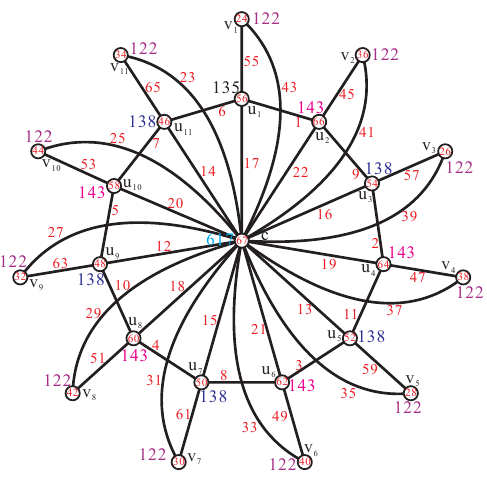
Figure 17. The local antimagic total labeling of F 11 . Example 6. The local antimagic total labelings of the graph F 10 and F 12 are shown in Figures 18 and 19.